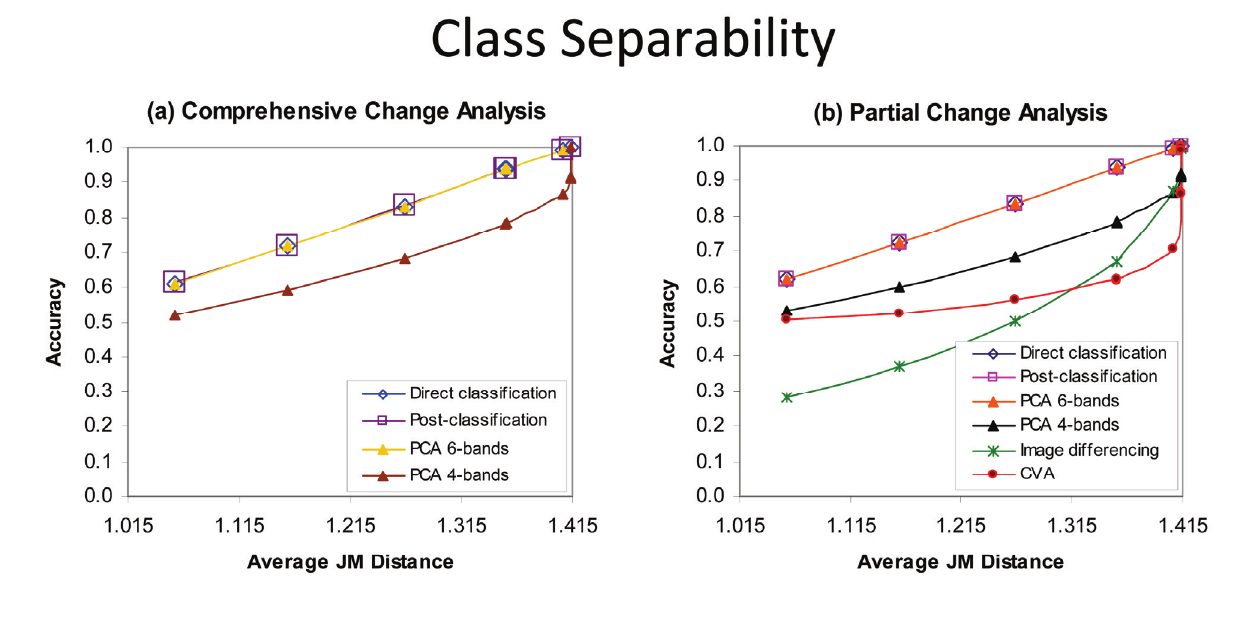
Figure 6. Effect of class spectral separability, measured by average divergence, on accuracy of comprehensive and partial change analysis methods, for the simulated